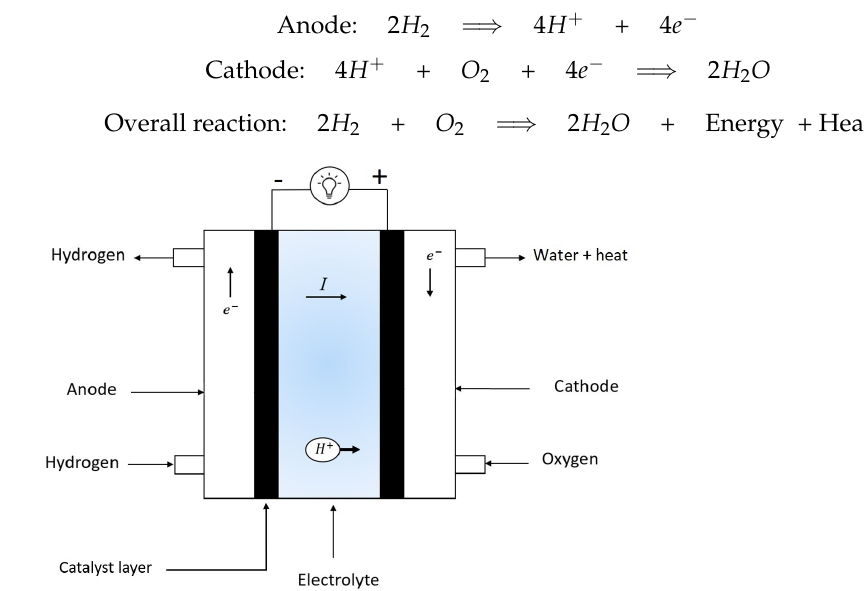
Figure 1. Cross section of a single